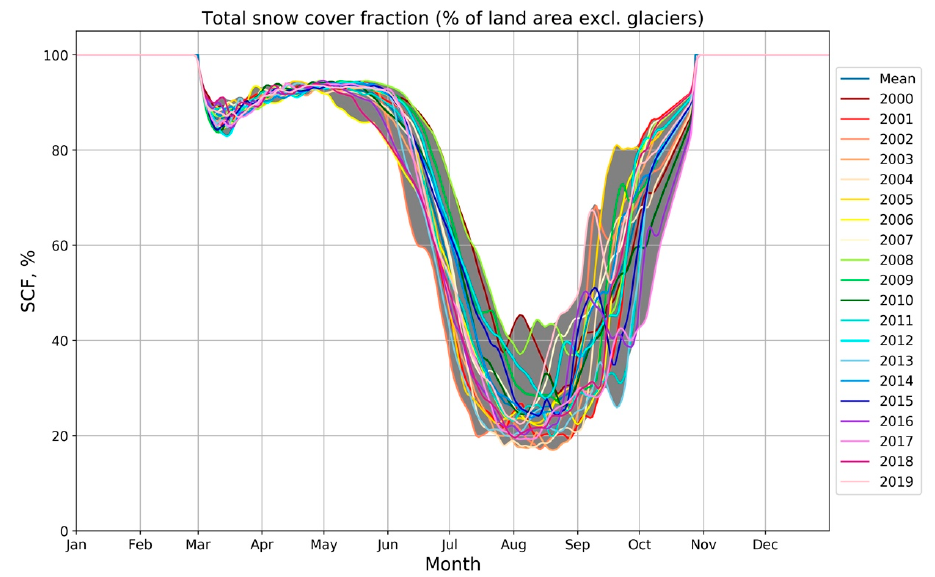
Figure 4. Total snow cover fraction over Svalbard as a function of months for all 20 snow seasons.